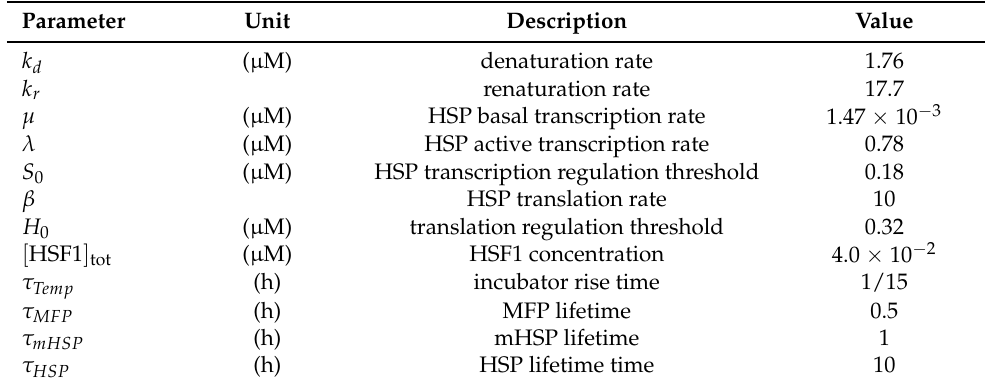
Table 1. Estimated Parameter of the heat shock response